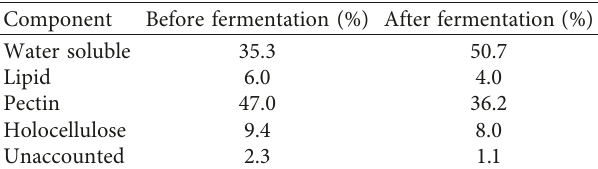
Table 2: The composition of coffee mucilage before and after complete